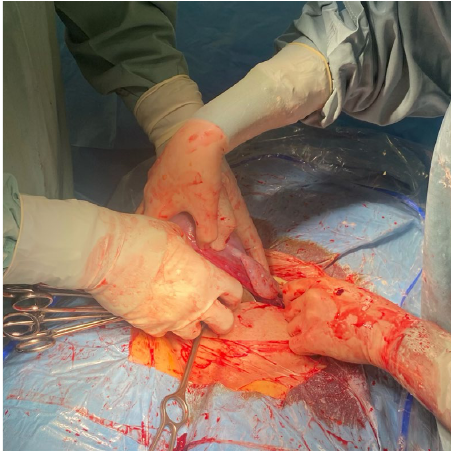
Figure 1. The assistant extracts the uterus from the abdomen by gently grasping the fundus of the uterus and pulling it upward and forward.